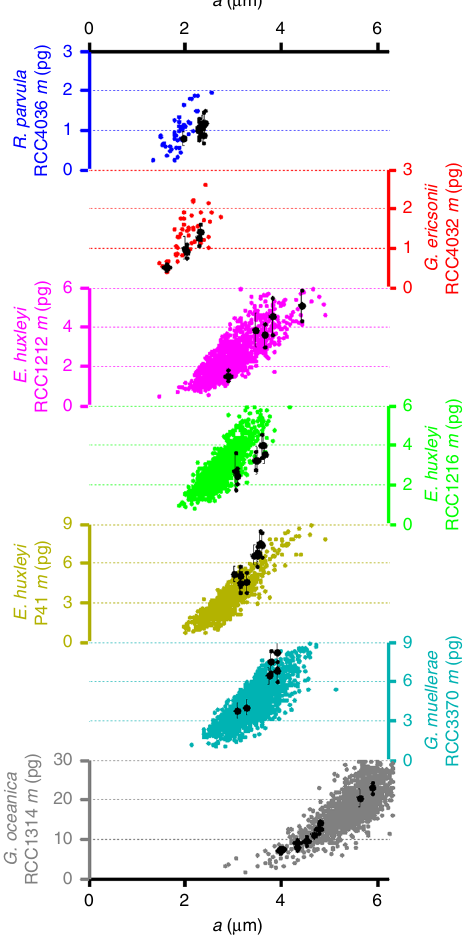
Fig. 3 Mass of coccoliths m as a function of their major axis a from PLM and 3D-CXDI measurements. For 3D-CXDI (black dots), the variability includes only the intra-coccosphere variability (i.e., the coccolith mass variability within a single coccolithophore for each species). For PLM (colored dots), the variability in size and mass results from the intra- and inter- coccosphere variabilities. For the two methods coccoliths originate from the same